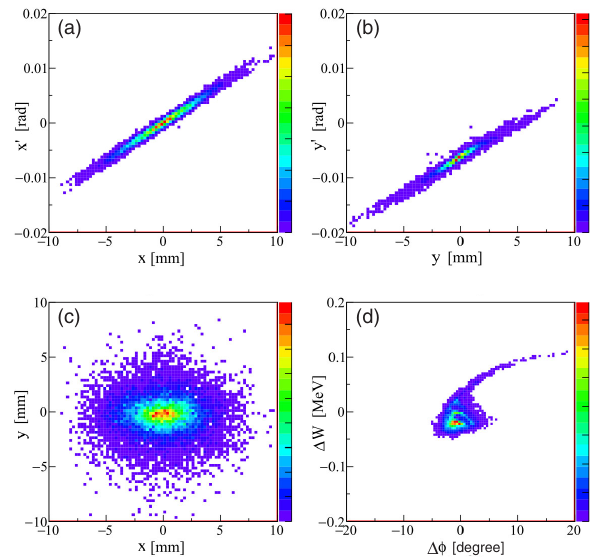
), blue: emittance x ), green: emittance growth in the FIG. 8. Calculated phase space distributions at IH exit. (a) the y ) and the horizontal divergence angle x 0 vs x , (b) the vertical y ). x